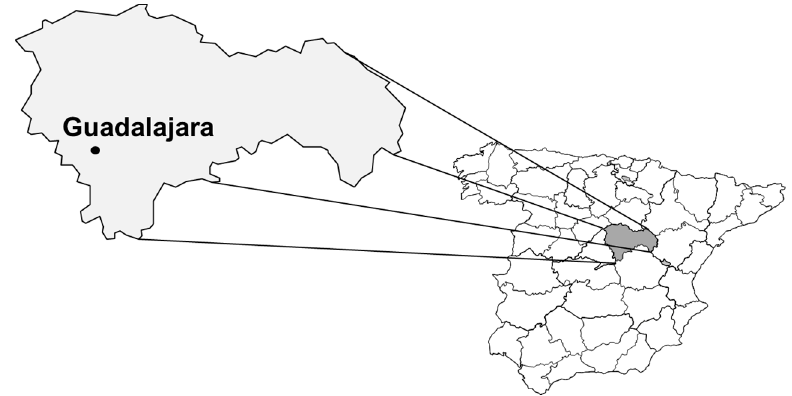
Figure 1. Guadalajara province.